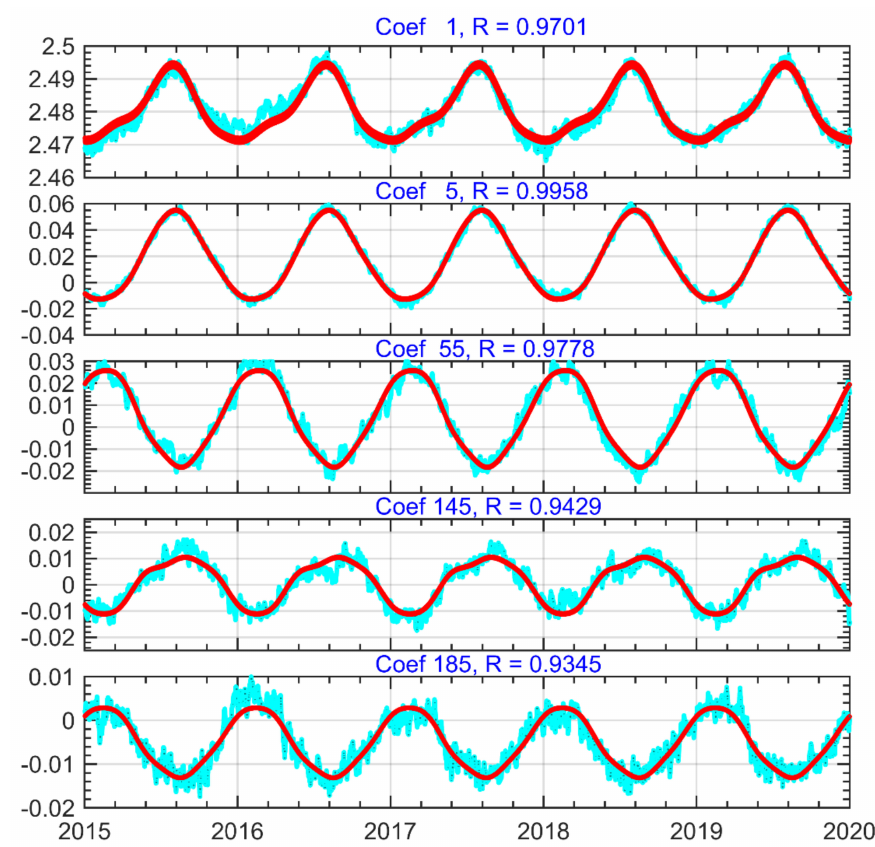
Figure 7. Time series of SH coefficients between EGtrop and SH_set for the period 2015 − 2019. Cyan spots represent SH coefficients provide by SH_set, and red spots represent SH coefficients derived by